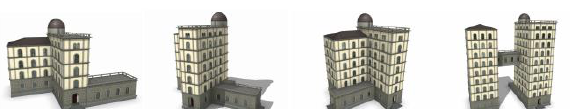
Figure 7 Application of CGA shape on building (Muller et